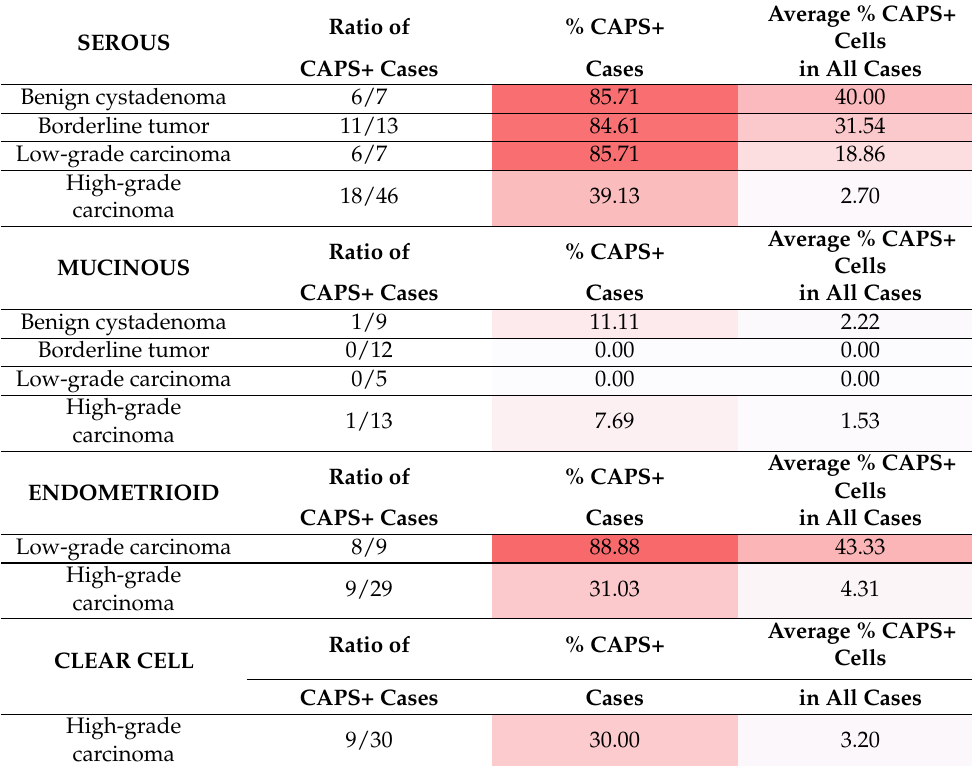
Table 1. Summary of CAPS immunostaining results in ovarian